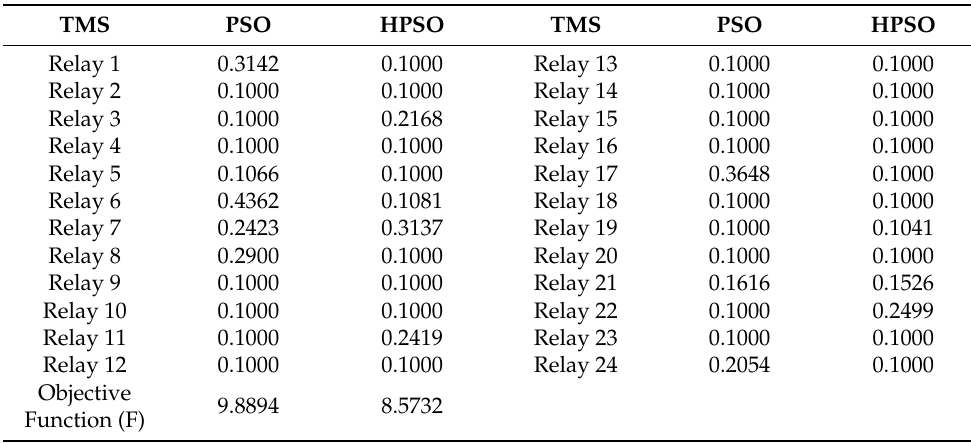
Table 3. Optimized TMS of PSO and HPSO of IEEE 9-Bus